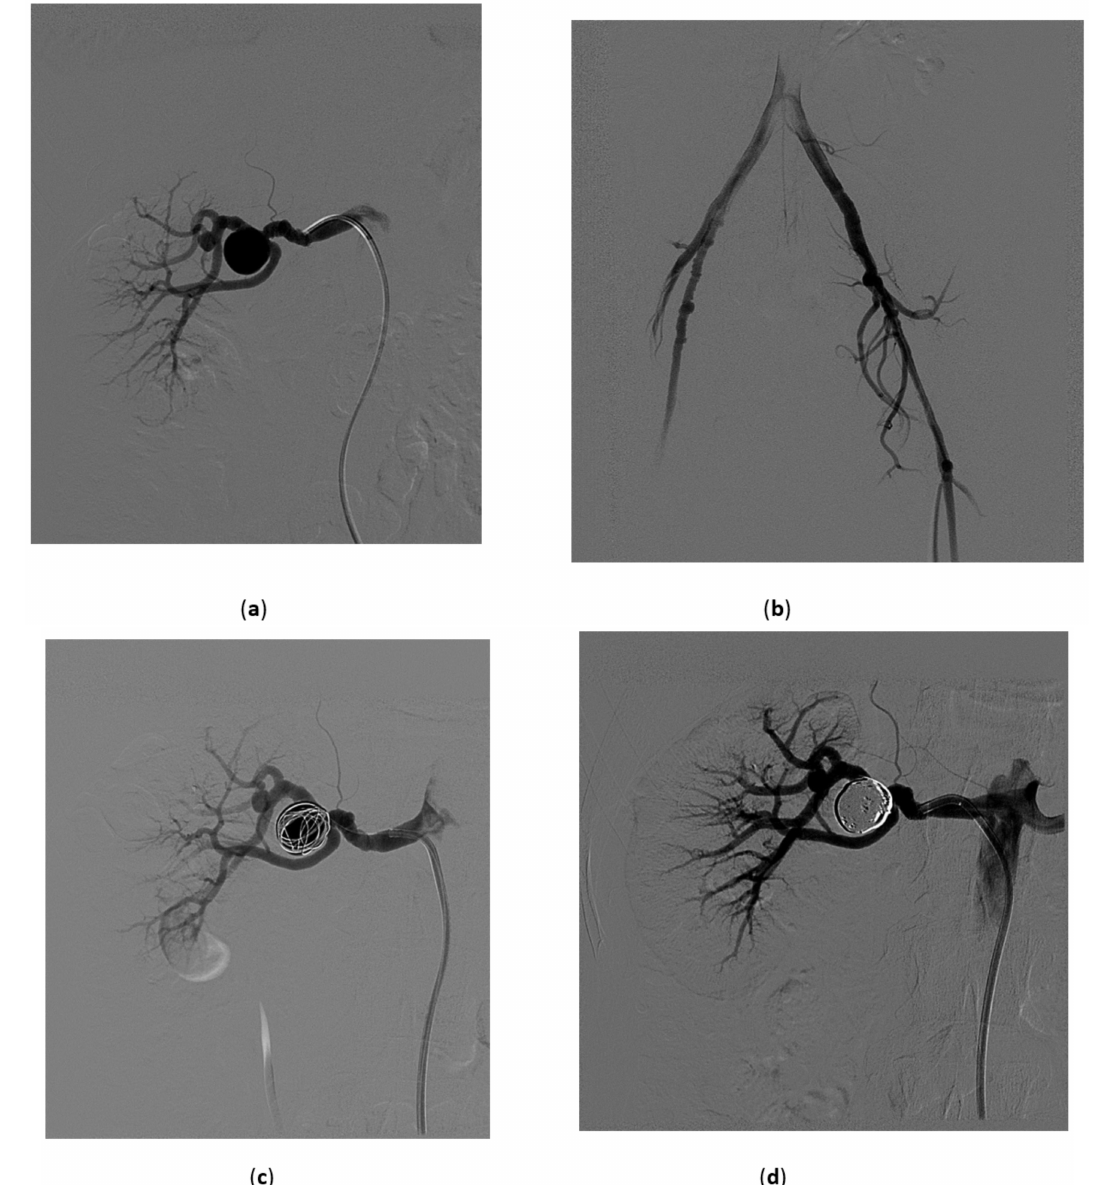
Figure 1. Renal artery aneurysm. 43-year-old female, asymptomatic; at color Doppler Ultrasound (done for other reasons) a 2.5 cm aneurysm of the right renal artery was discovered. ( a ) Preliminary angiogram confirms the aneurysm at the bifurcation of the main trunk. Slight aspects of fibromuscular dysplasia are visible on the distal main trunk. A second small aneurysm is visible on a distal branch; ( b ) An angiogram done on the iliac arteries confirm the diagnosis of fibromuscular dysplasia which is clearly visible on the right external iliac artery; ( c ) Angiogram after deployment of the first detachable microcoil; ( d ) Final angiogram after deployment of 250 cm of